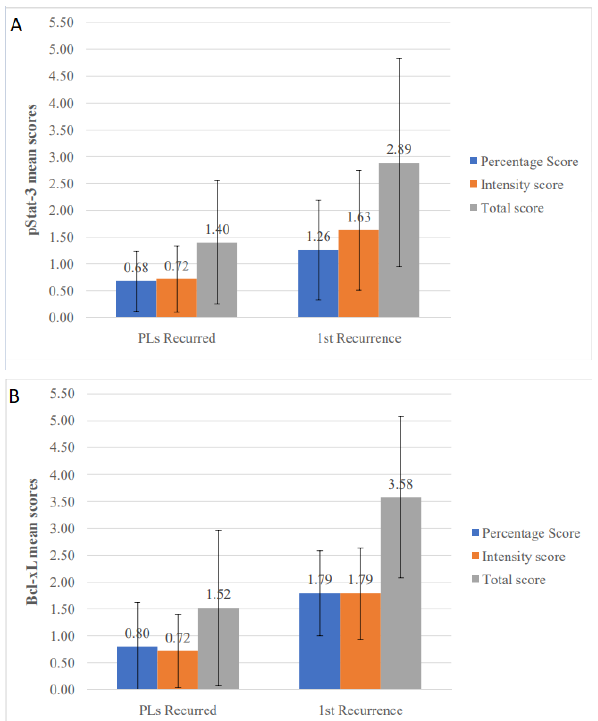
Figure 6. Comparison of immunohistochemical mean scores of ( A ) pSTAT3 and ( B ) Bcl-xL, between primary oral leukoplakia lesions (PLs) that recurred and their corresponding first recur- rences.